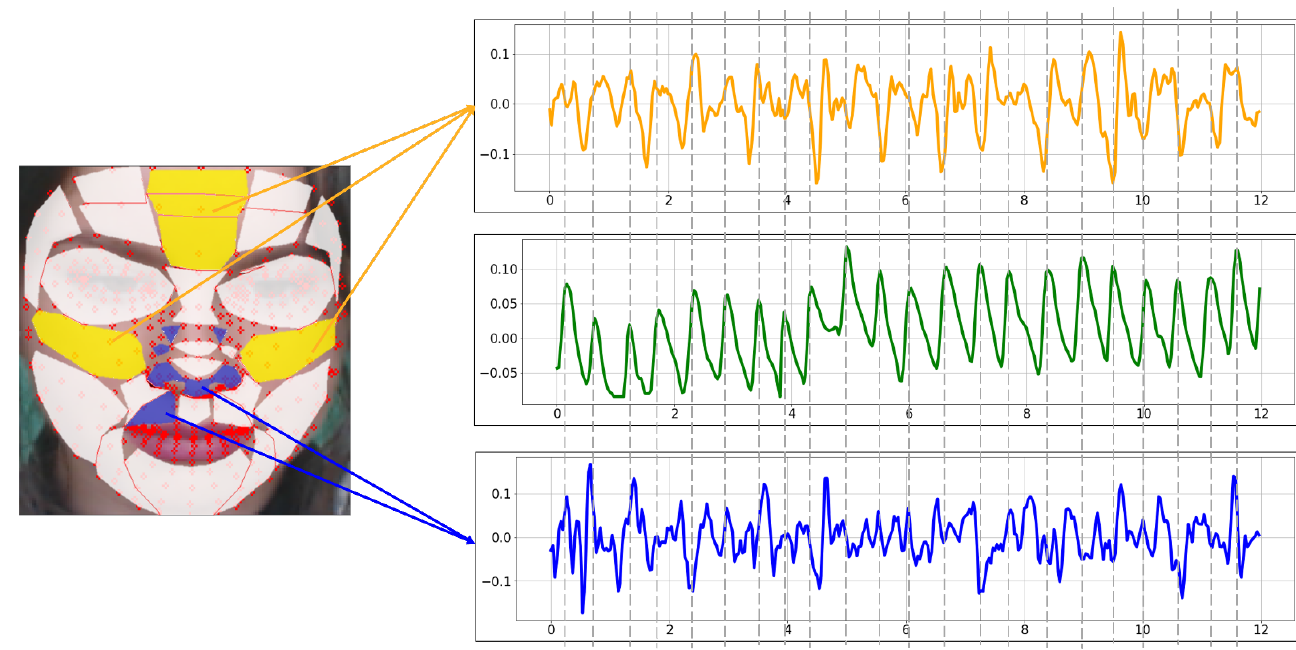
Figure 11. rPPG signal extracted with the proposed ROI using POS (yellow: TOP-5, green: ground truth, blue: BOT-5).